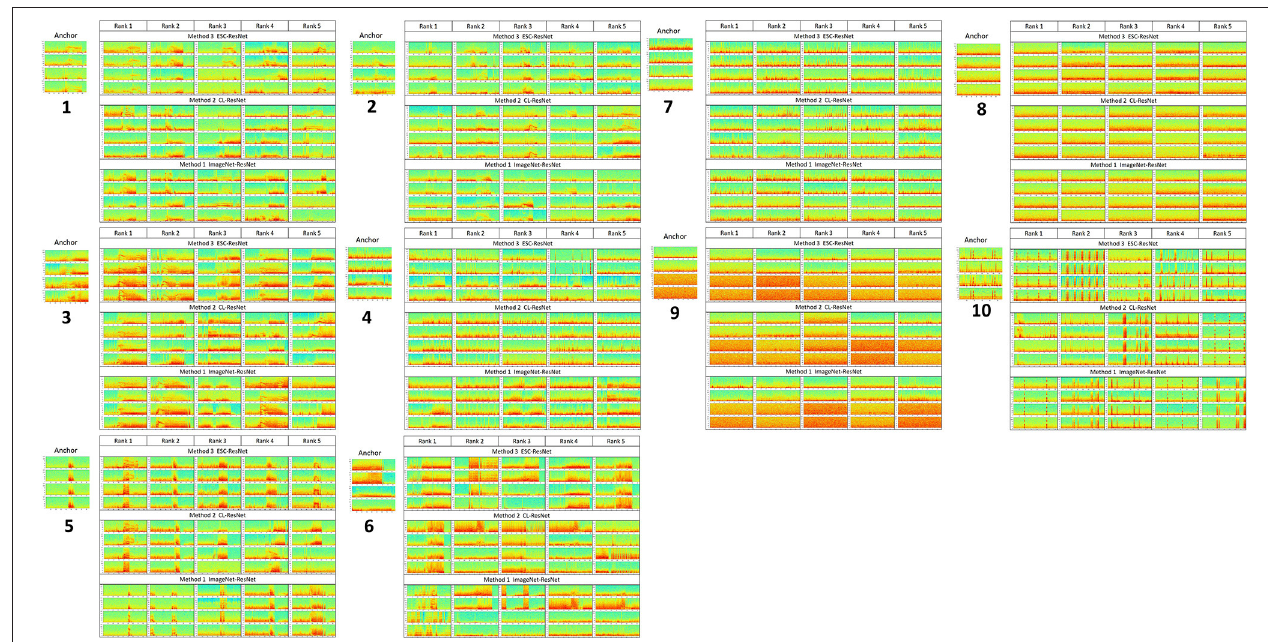
FIGURE 8 | The 5 highest ranked iEEG search records for each of the 10 query iEEG records and their channel